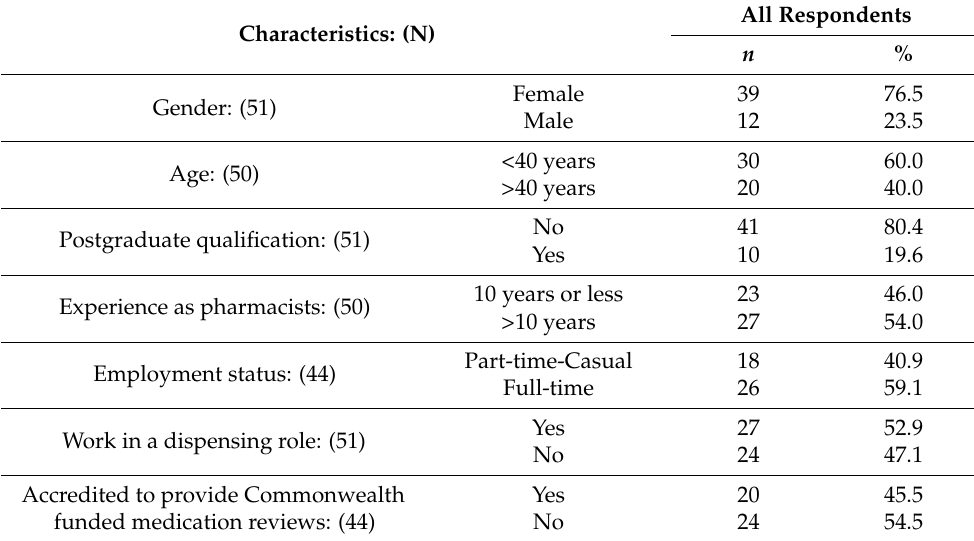
Table 2. Socio-demographic and role characteristics of the respondents.